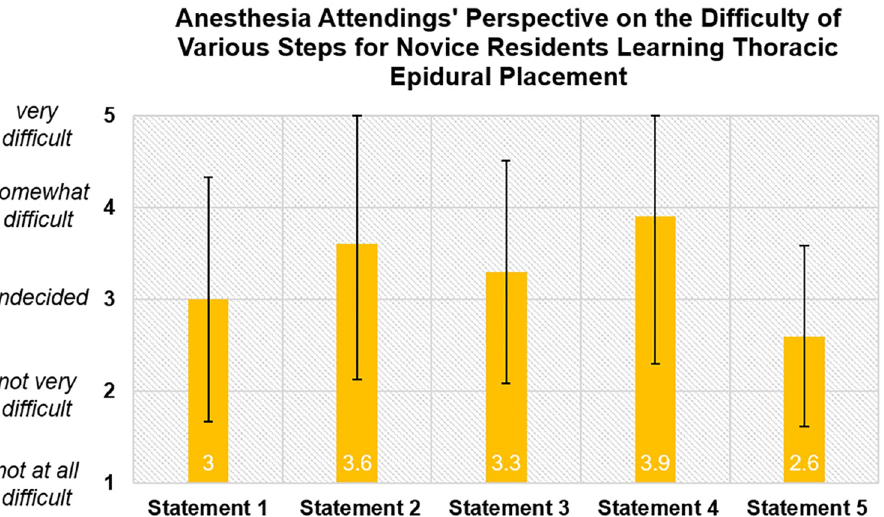
Fig 4. Anesthesia attendings’ perspective on the difficulty of various steps for novice residents learning thoracic epidural placement. Statement 1. Identifying landmarks on back / identifying different thoracic levels. Statement 2. Determining where to place needle on patient’s back and determining needle approach. Statement 3. How to feel and identify the different layers with needle (soft tissue, bone, ligamentum flavum). Statement 4. How to mentally visualize the location of the needle tip with redirection at skin. Statement 5. How to feel the “loss of resistance”.